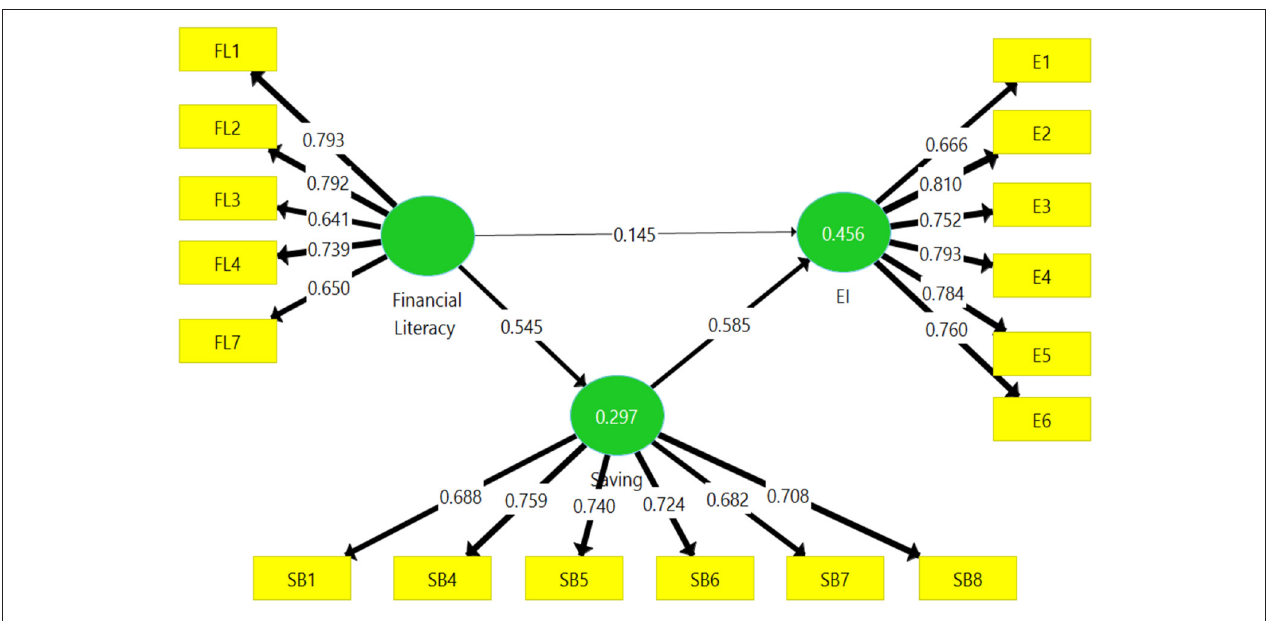
FIGURE 2 | Path coefficient results. Source: Primary